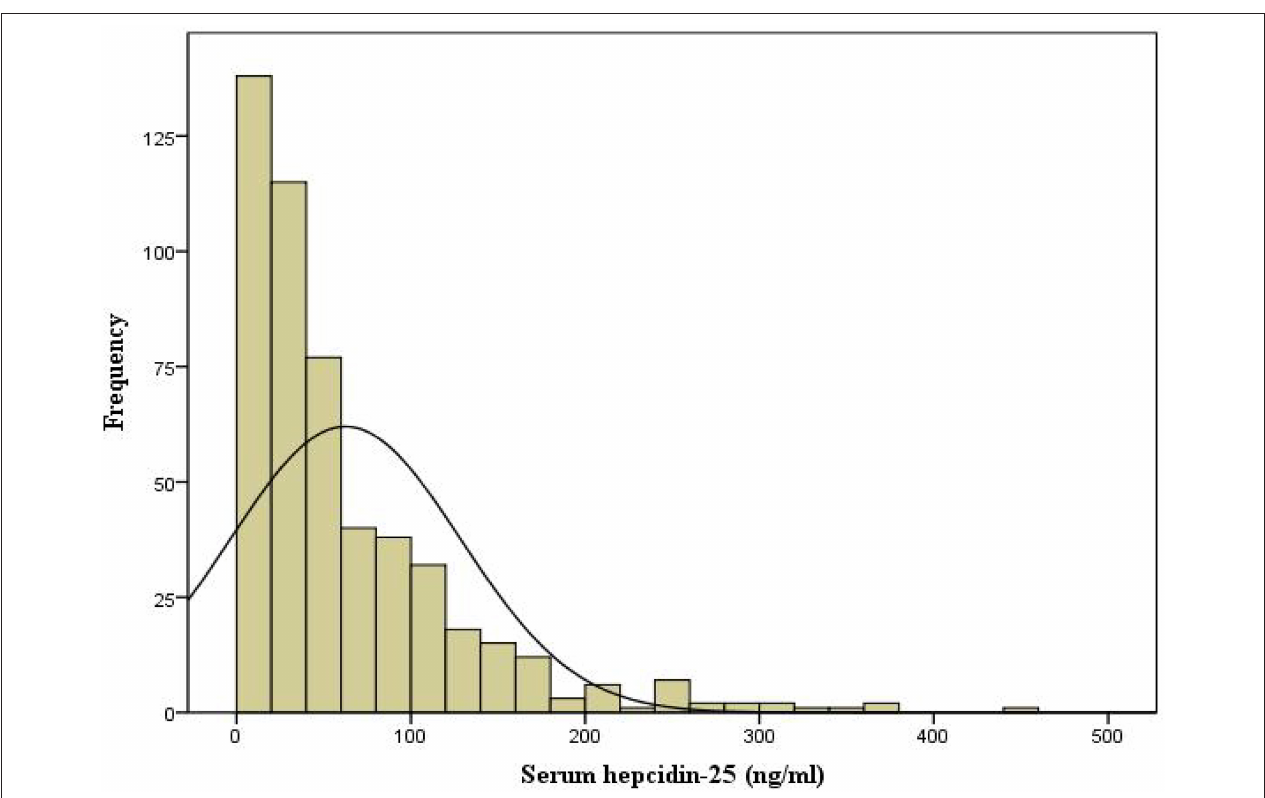
FIGURE 2 | Distribution of serum hepcidin-25 in our cohort.